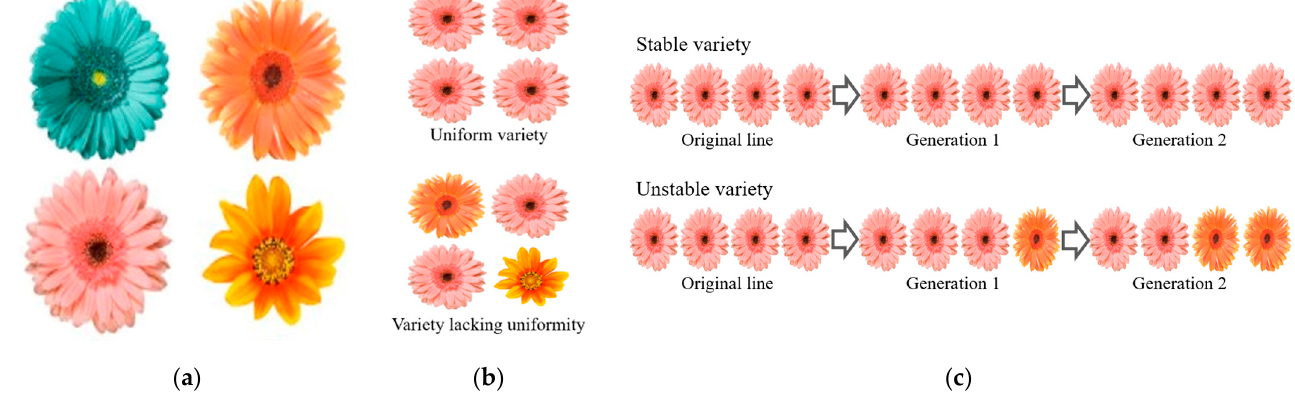
Figure 1. Illustration of DUS definitions. ( a ) Distinctness; ( b ) Uniformity; ( c ) Stability.